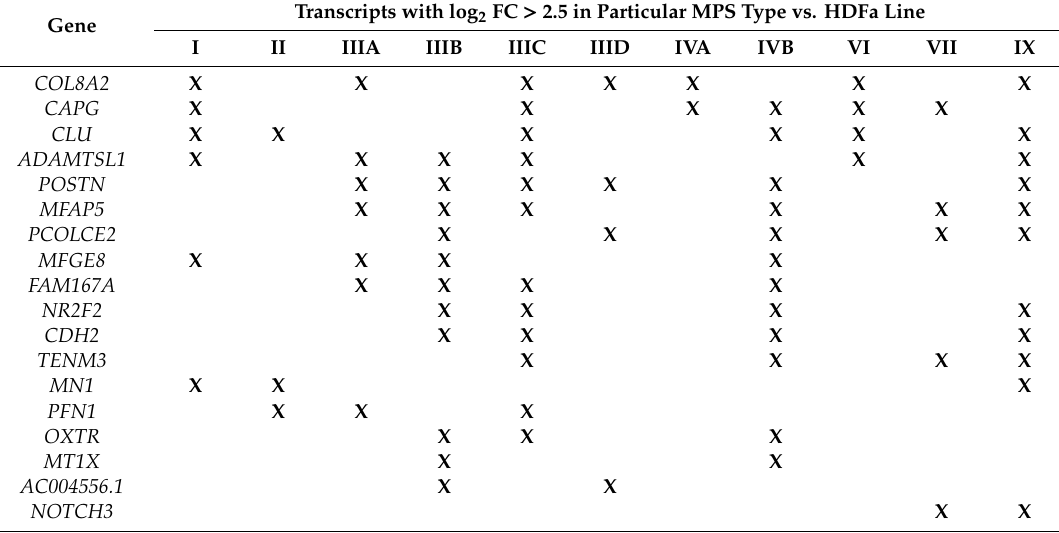
Table 4. Selected up-regulated (bold X ) and down-regulated (italic X ) genes, with log 2 FC > 2.5 in di ff erent types of MPS relative to control cells (HDFa), which are characterized with severe changes in expression in at least two di ff erent types of MPS. Detailed statistical analysis is shown in Tables